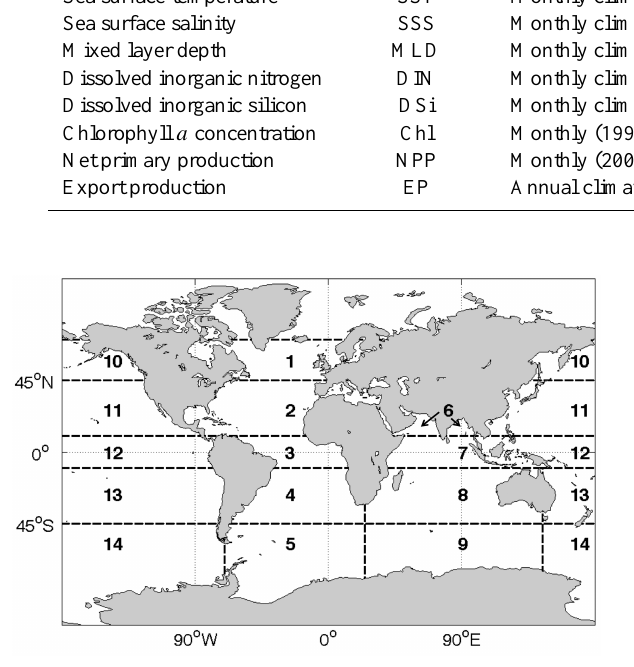
Figure 3. Map of the ocean regions used to examine the model re- sults on a basin